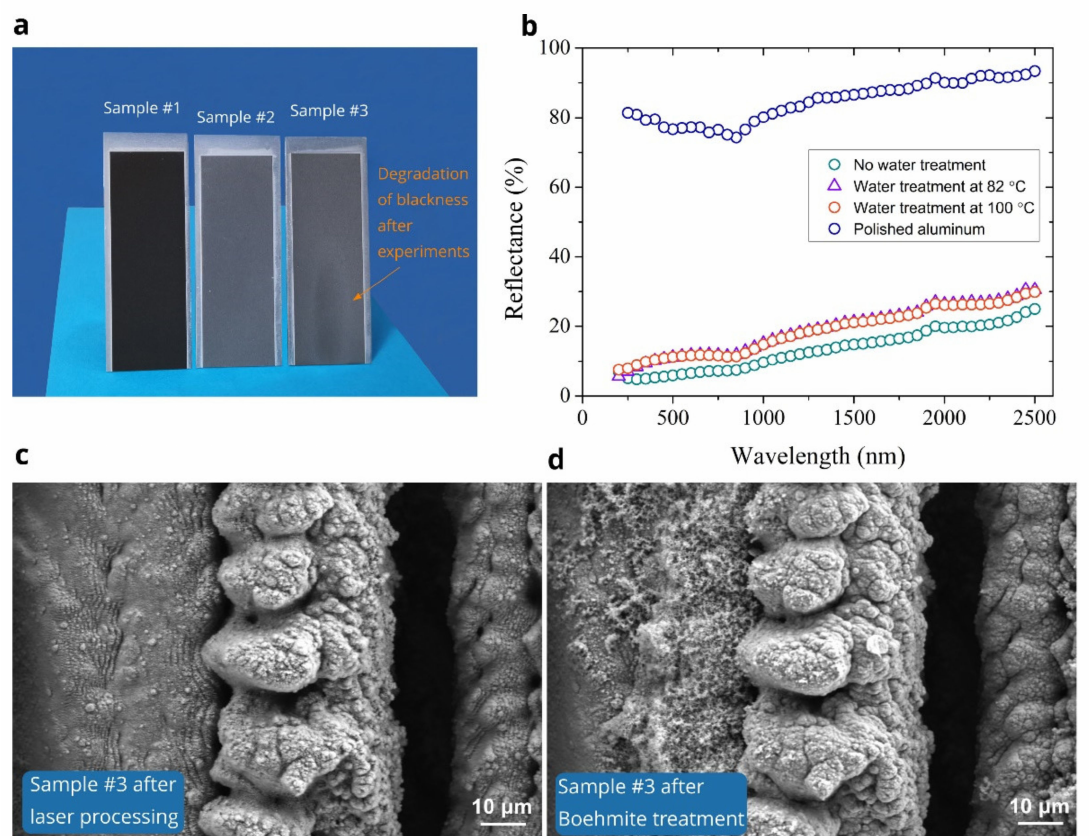
Figure 8. ( a ) Photos of the samples #1 (after laser processing), #2 (after Boehmite treatment at 82 ◦ C), and #3 (Boehmite- treated at 100 ◦ C and studied for wicking properties). ( b ) Reflectance of aluminum samples as a function of the light wavelength λ . For a comparison, the R ( λ ) of a polished sample before laser processing is also shown. ( c ) SEM image of the surface of the sample #3 after laser processing. ( d ) SEM image of the same surface of the sample #3 after Boehmite